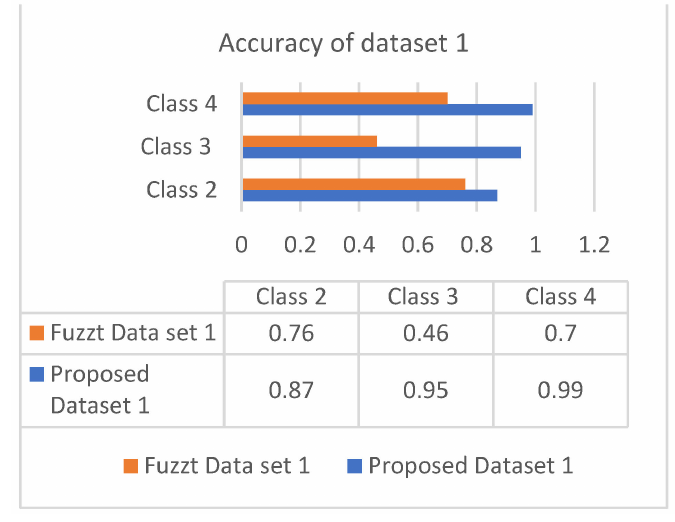
Figure 6. Accuracy of dataset 1.